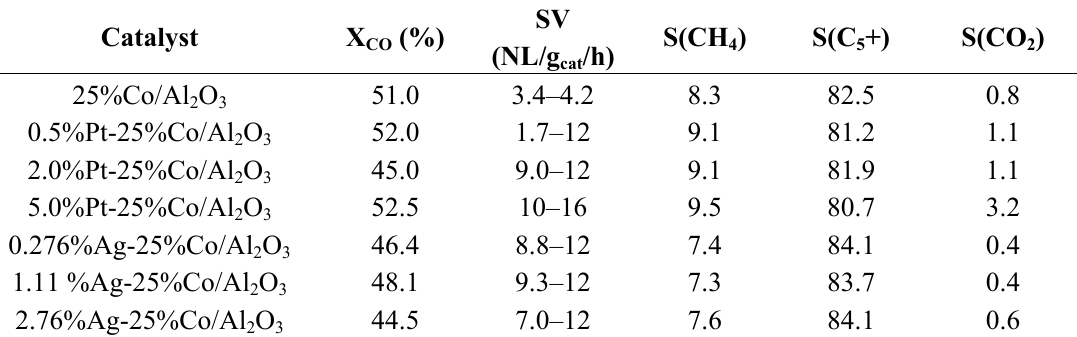
Table 7. Product selectivity * of 25%Co/Al and Pt (adapted with permission from [28] Copyright 2013,